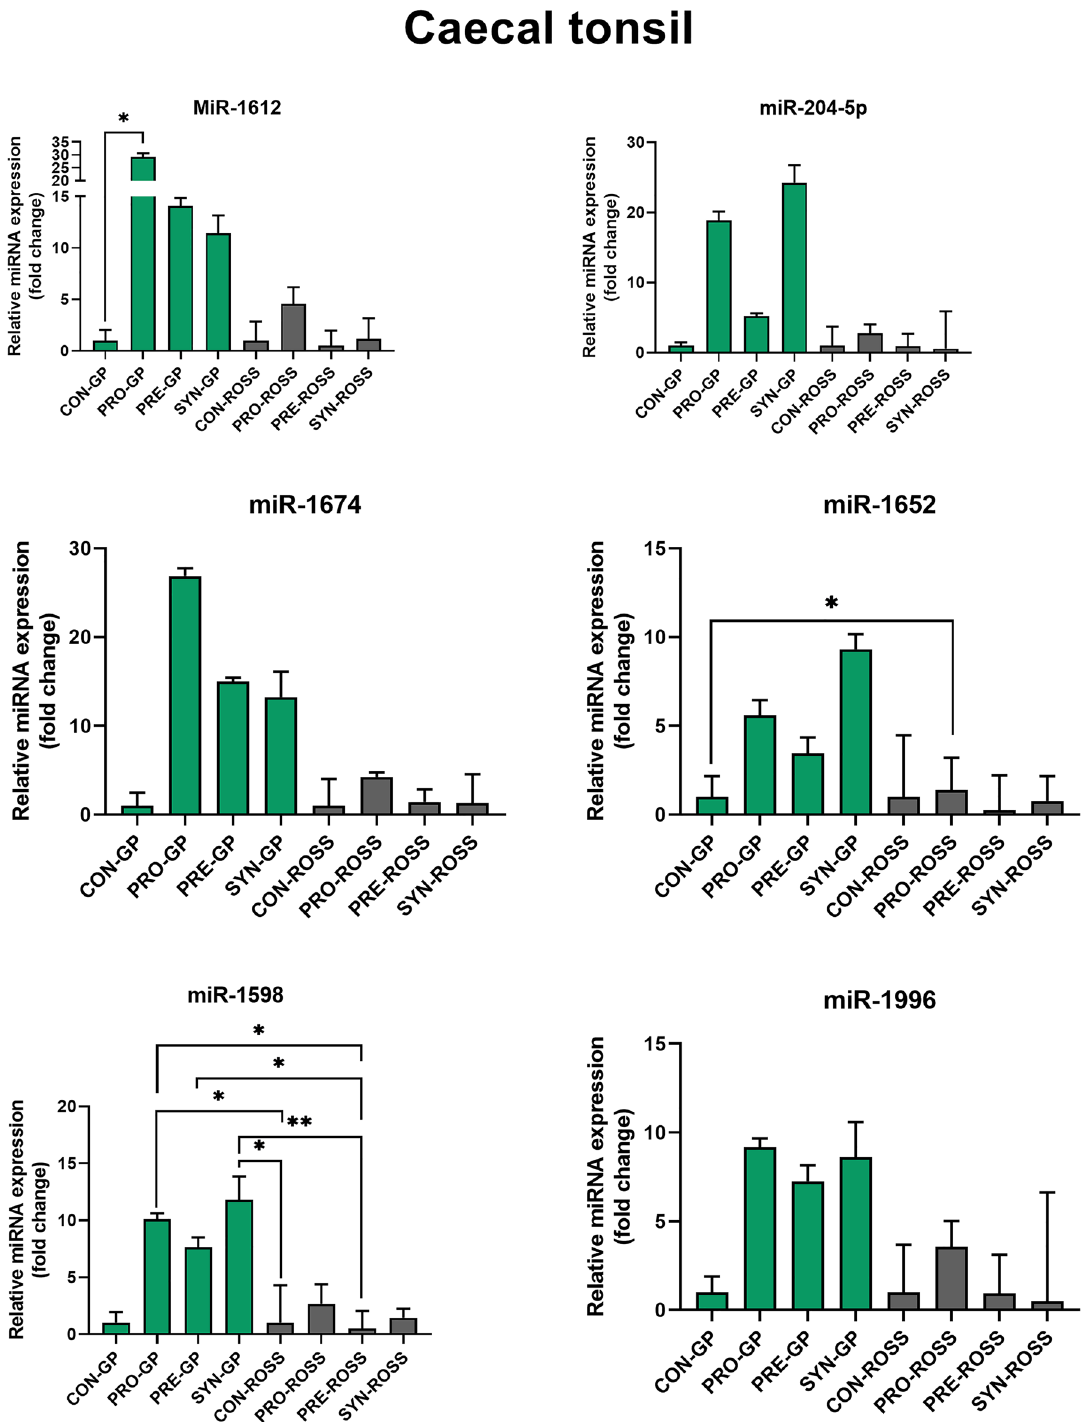
Figure 2. The Relative microRNA (miR) expression in the caecal tonsil of Green-legged partridgelike chickens (GP) and ROSS 308 broilers (ROSS) injected in ovo with saline-CON, probiotic-PRO, prebiotic-PRE, and